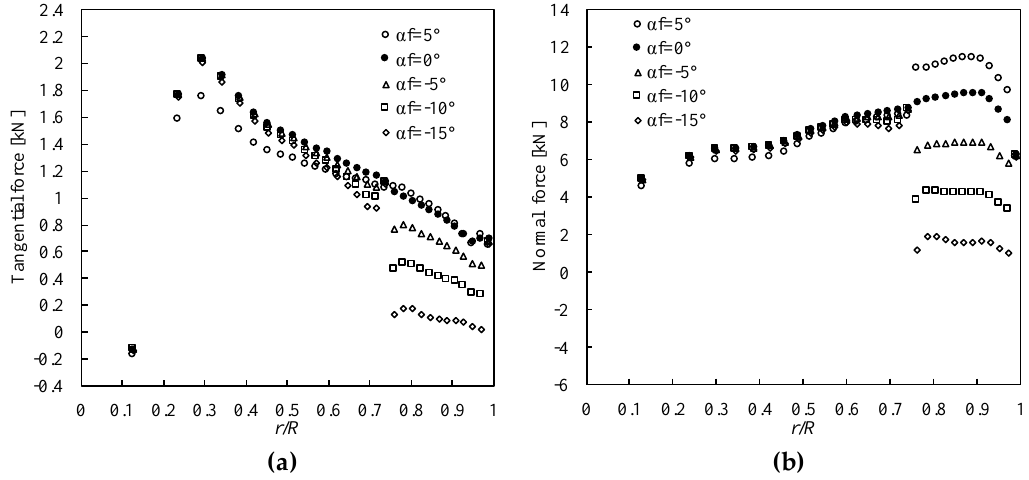
Figure 6. Aerodynamic force distribution of the blade control points for U = 8 m/s. ( a ) Tangential force to the rotor disc, ( b ) Normal force to the rotor disc.